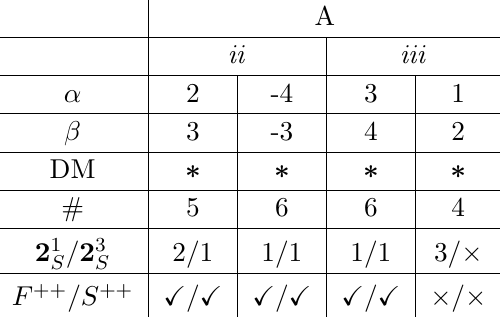
and 2 3 present S S